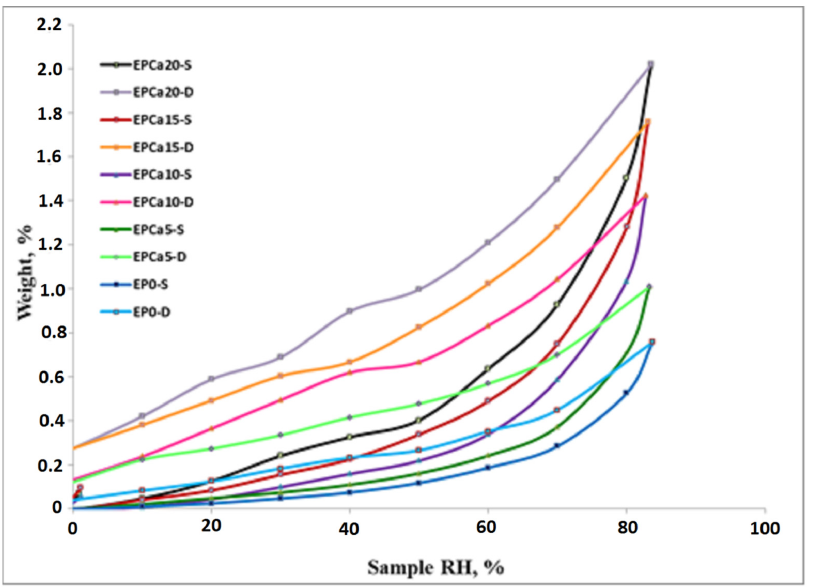
Figure 7. Sorption/desorption isotherms of EPDM/hemp fiber composites (S—sorption; D— Figure 7. desorption).